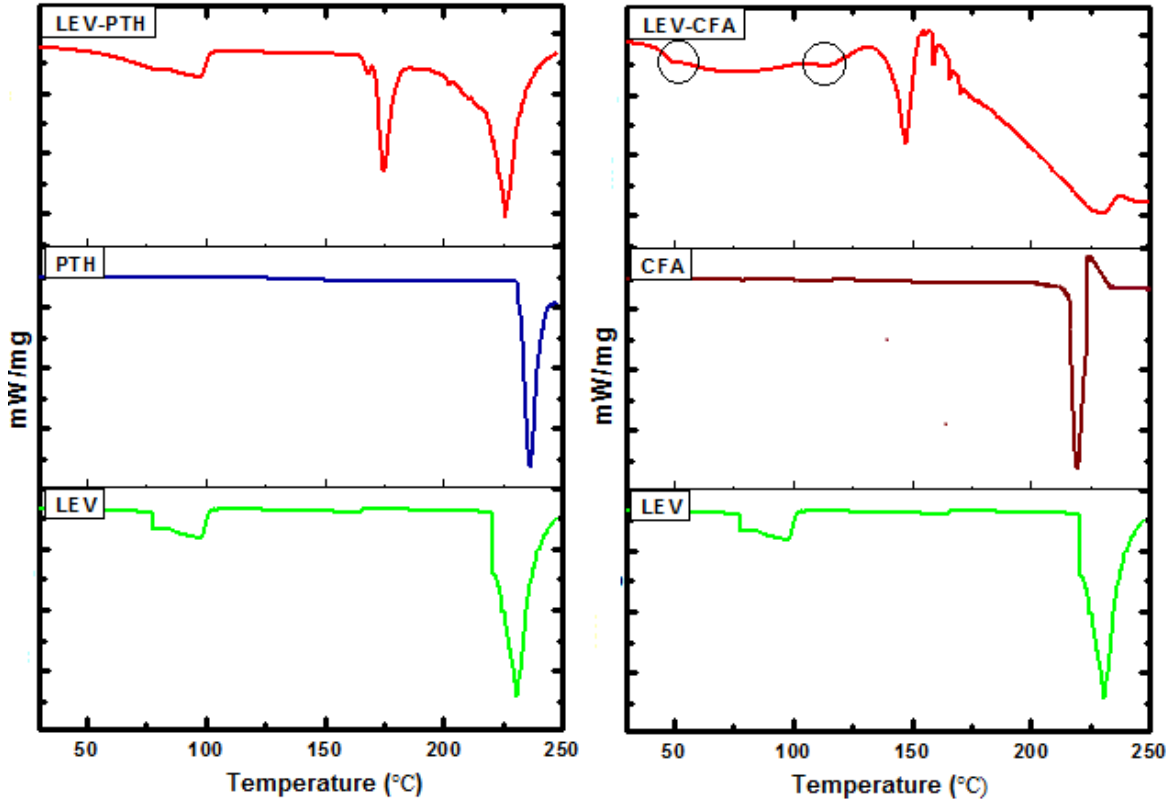
Figure 5. DSC thermograms of cocrystal (LEV-PTH), amorphous salt (LEV-CFA) and their respective pure components.